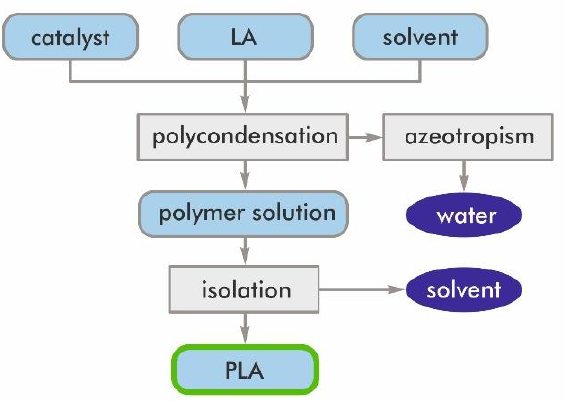
Figure 7. Flow diagram of the azeotropic dehydrative polycondensation of LA [28].